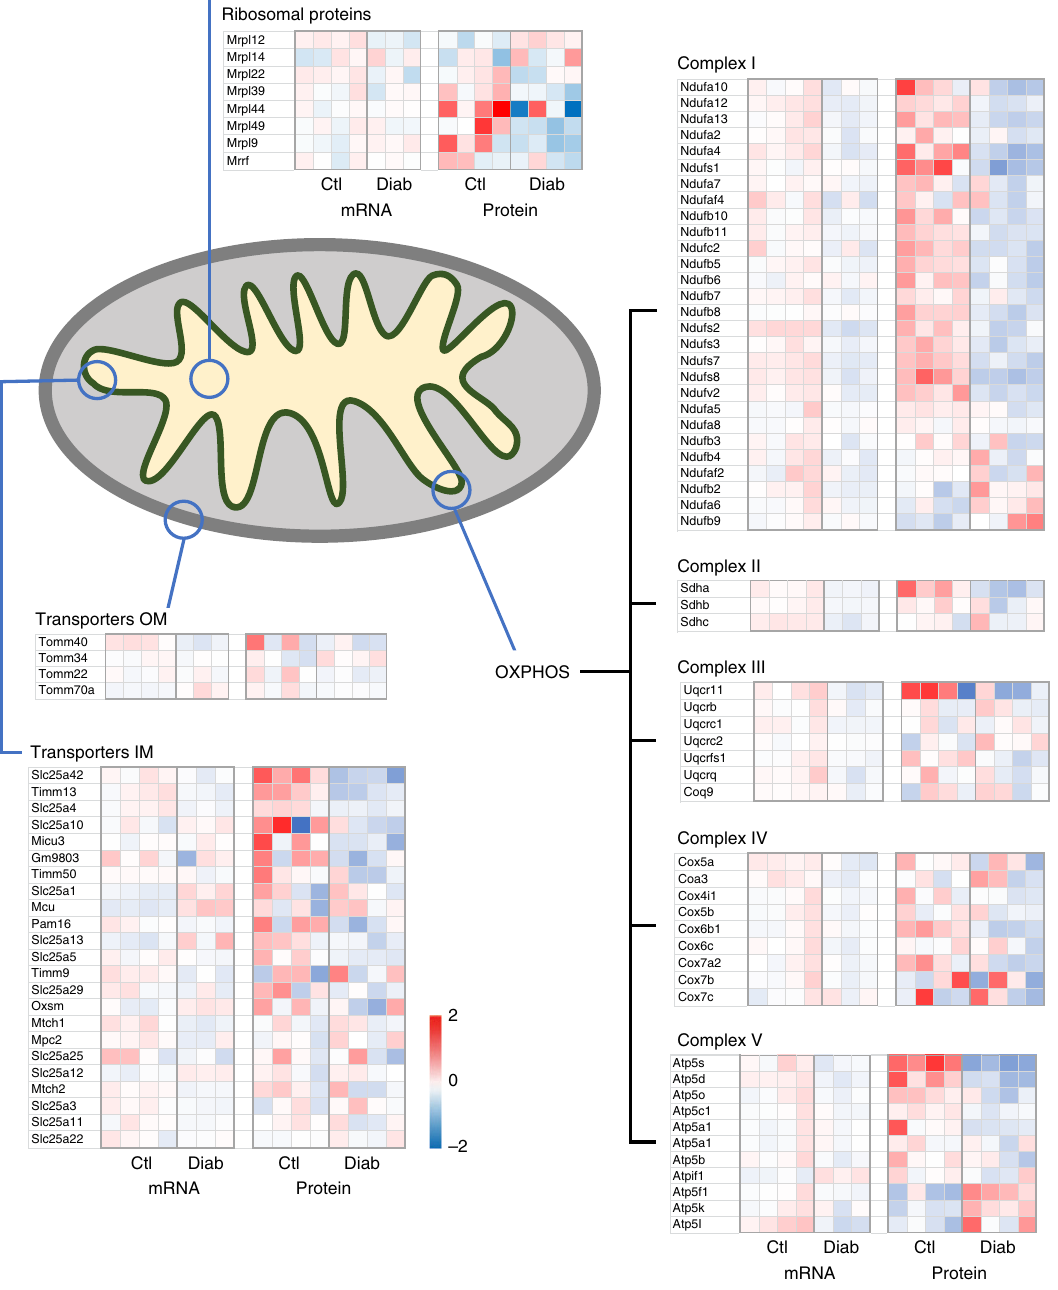
Fig. 3 Mitochondrial signatures in control (Ctl) and diabetic (Diab) islets. Heat maps of mRNA and protein levels of the indicated mitochondrial genes in islets isolated from control and 2-week diabetic β V59M mice. Each box represents a different animal. Colour indicates log 2